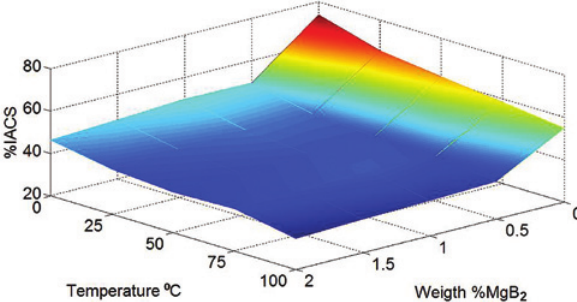
nanoparticles amount and temperature Figure 7: Effect of the MgB 2 on the electrical conductivity of Al – 1 wt.%Mg wires (measured as percent of IACS).